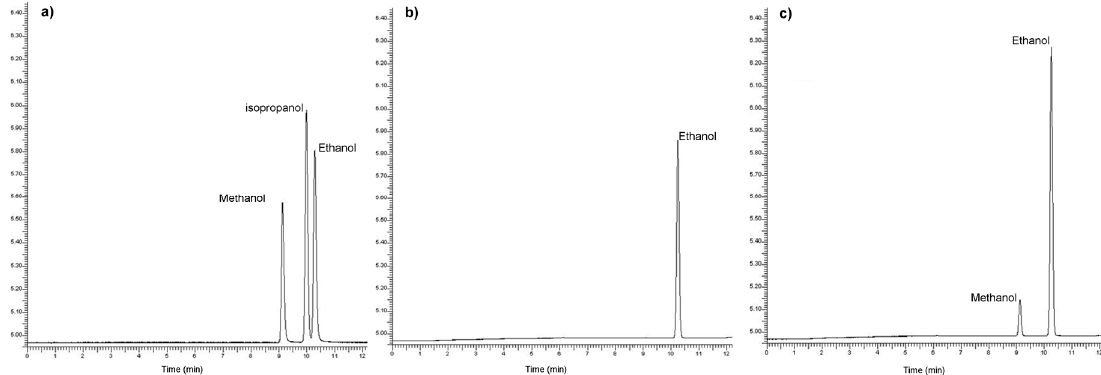
Figure 5. GC chromatogram of the B. alicastrum distillation product fermented with two yeast strains: ( a ) Internal standard; ( b ) S. cerevisiae (Safoeno ® ); and ( c ) C. tropicalis (PL1).